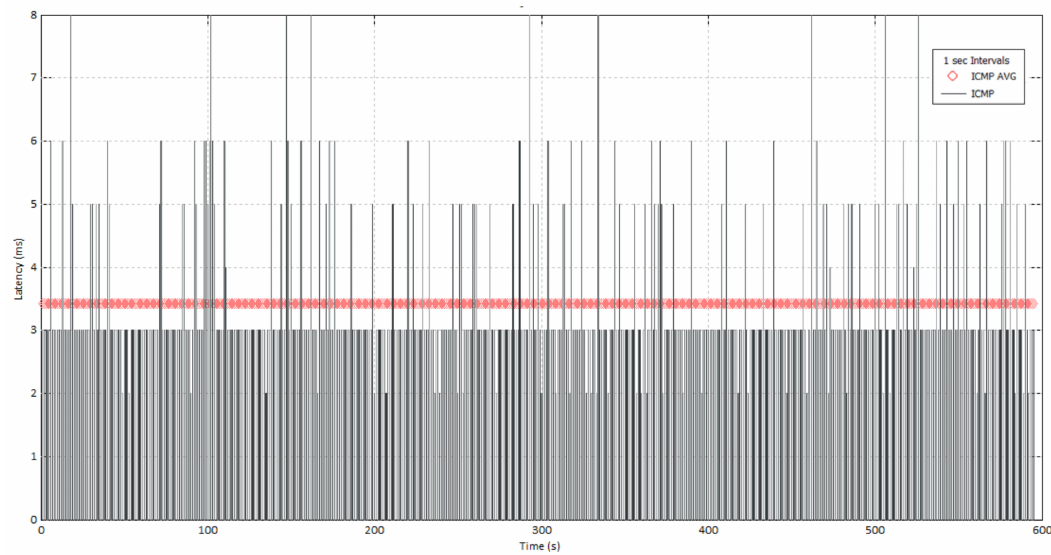
Figure 6. 5G gNB FR1 OTA E2E latency measured using an EMITE F200 reverberation chamber.